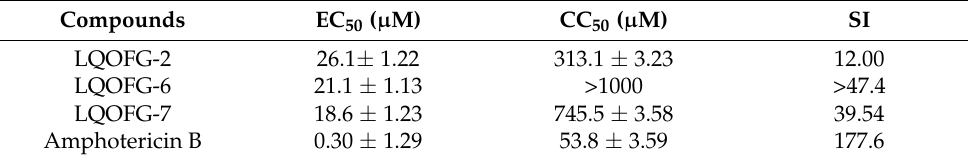
Table 2. Half-maximal effective concentration (EC 50 ) of axenic amastigotes treated with LQOFG-2, LQOFG-6, LQOFG-7, and AmB as the positive control, cytotoxicity in PBMC cells (CC 50 ), and the selectivity index (SI, CC 50 /EC 50 ).